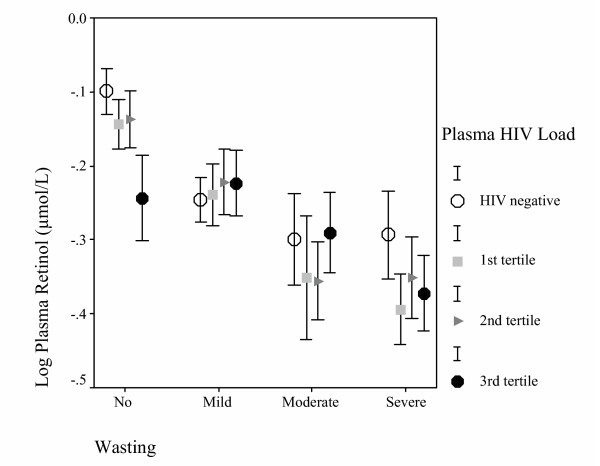
Log-transformed mean plasma retinol concentrations with 95% C.I. are depicted by severity of wasting and plasma HIV load. Among the not-wasted adults with pulmonary tuberculosis log mean plasma retinol concentration significantly decrease with the increase of plasma HIV load (P = 0.004). Among those with mild, moderate and severe wasting this linear trend did not reach significance. Among the HIV negative adults with pulmonary tuberculosis, log mean plasma retinol concentration significantly decrease with the increasing severity of wasting (P = 0.0001). The same trend appears among those in the 1st, 2nd and 3rd tertile of HIV load; P = 0.0001, P = 0.0001 and P = 0.01 respectively.